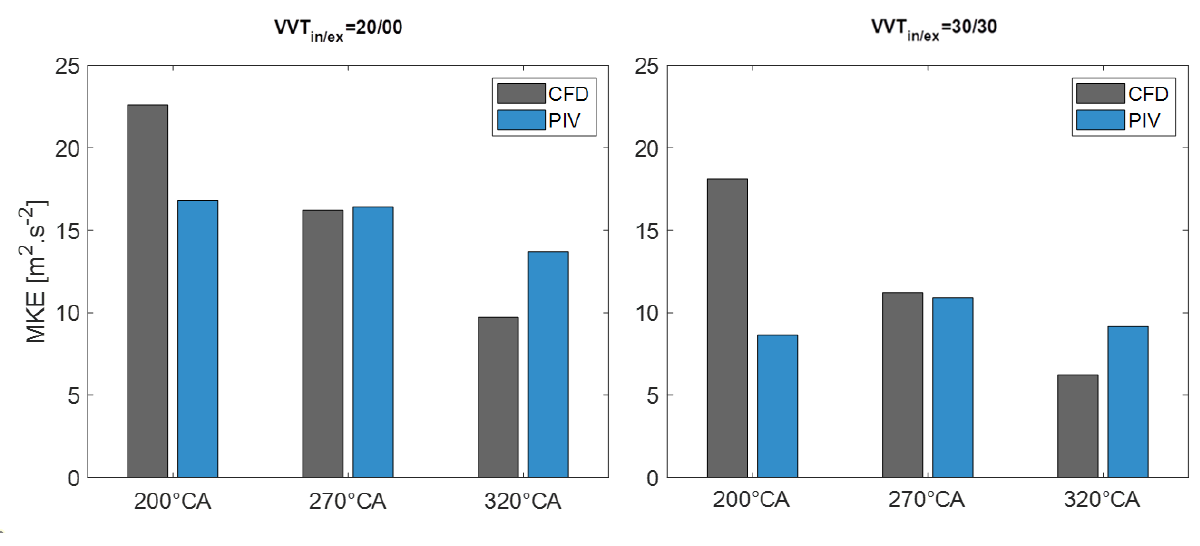
Figure 12. Comparison of the 2D mean kinetic energy: simulation vs. experiment .